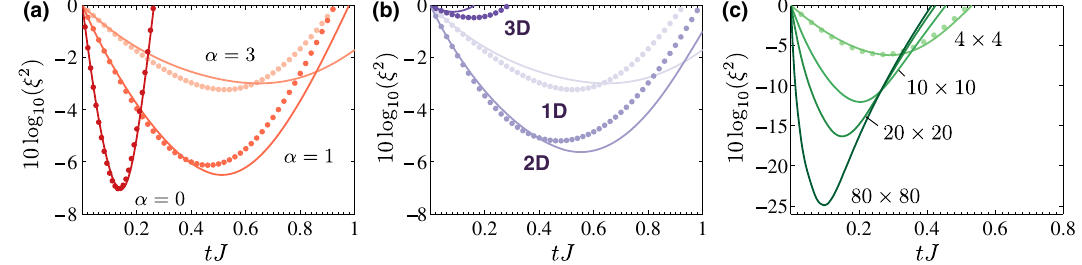
FIG. 5. Range of interactions and higher dimensions ( XY model). Circles denote exact diagonalization, solid lines DTWA results. The time evolution of the spin-squeezing parameter ξ is shown (a) in 1D ( N ¼ 20 spins) for different decay exponents α and (b) with fixed α ¼ 3 and for different dimensions (1D, 20 × 1 × 1 lattice; 2D, 5 × 4 × 1 ; 3D, 3 × 3 × 2 ). With increasing range of interactions, the DTWA improves and spin squeezing increases. (c) DTWA prediction for increasingly large 2D systems ( N ≤ 6400 ) with α ¼ 1 . The exact diagonalization result is shown for the 4 × 4